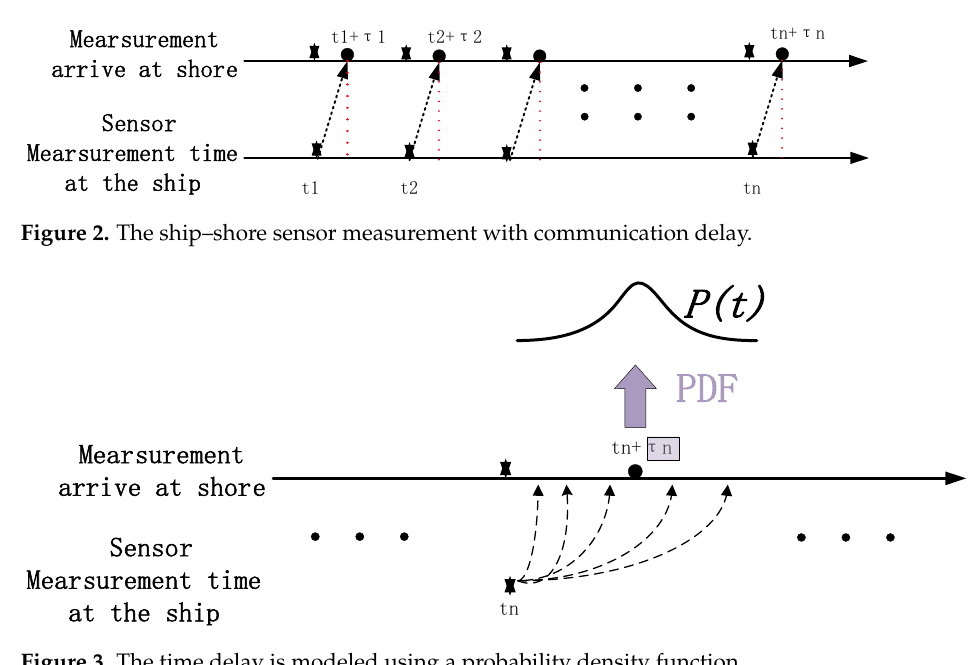
Figure 3. The time delay is modeled using a probability density function.